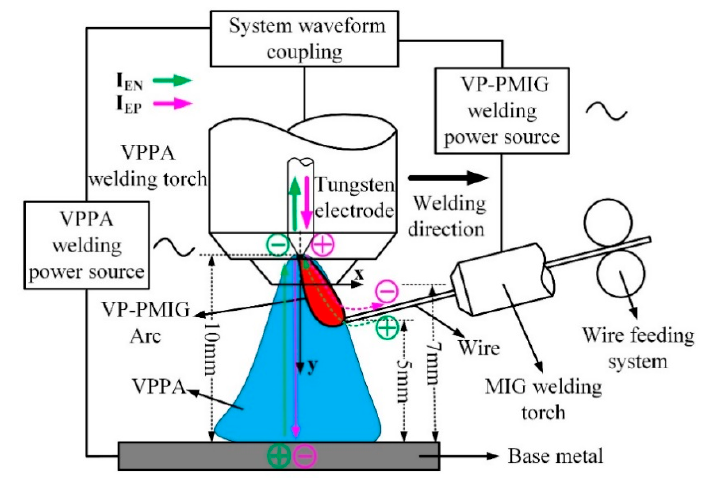
Figure 1. Schematic diagram of the coupling between the variable polarity plasma arc (VPPA) and variable polarity pulse metal inert-gas (VP-PMIG) arc.